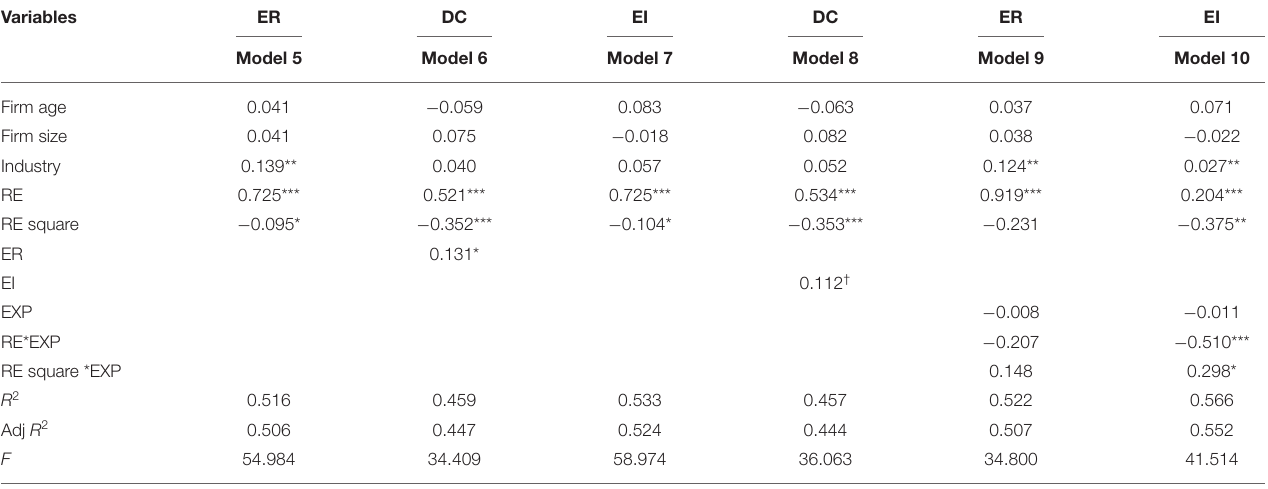
TABLE 4 | Results of mediation regression analysis and moderated regression analysis.